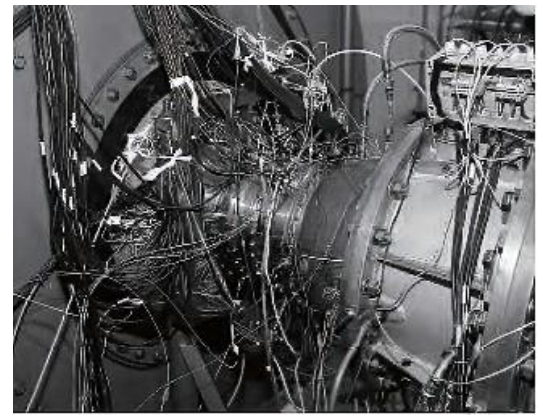
Figure 1. The test rig of